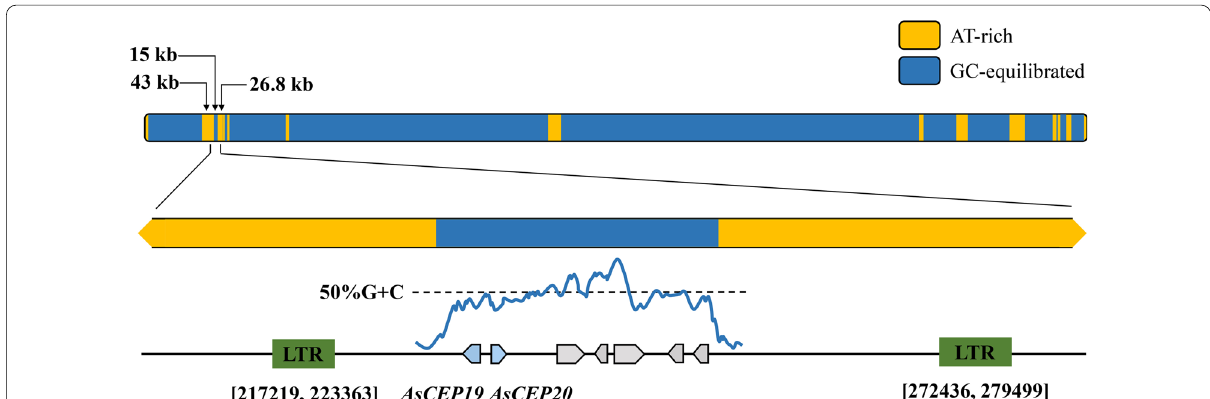
Fig. 3 Schematic diagram of the AsCEP19 and AsCEP20 loci on chromosome. The GC-equilibrated and AT-rich regions in the A. solani strain NL03003 chromosome 3 (CP022026.1.3) were shown in colors. Protein-coding genes and long terminal repeat (LTR) elements were shown as arrows and rectangles in colors, respectively. The GC content was shown along the selected region. In the 5’ to 3’ orientation, AsCEP19 is located between positions 244,287 and 243,852, and AsCEP20 is located between 246,214 and